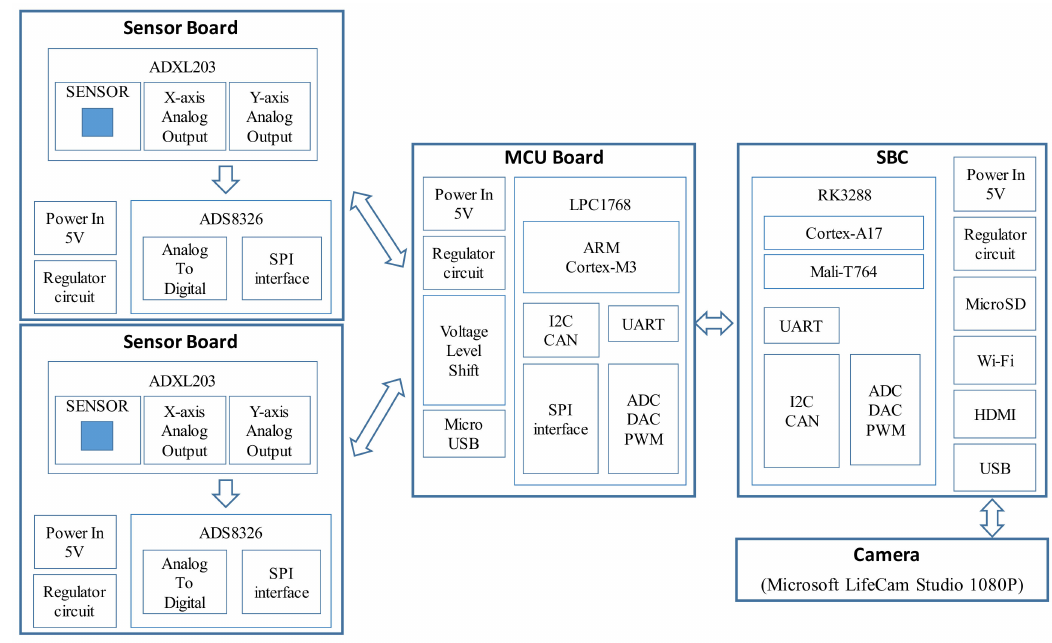
Figure 2. Component diagram of the smart camera